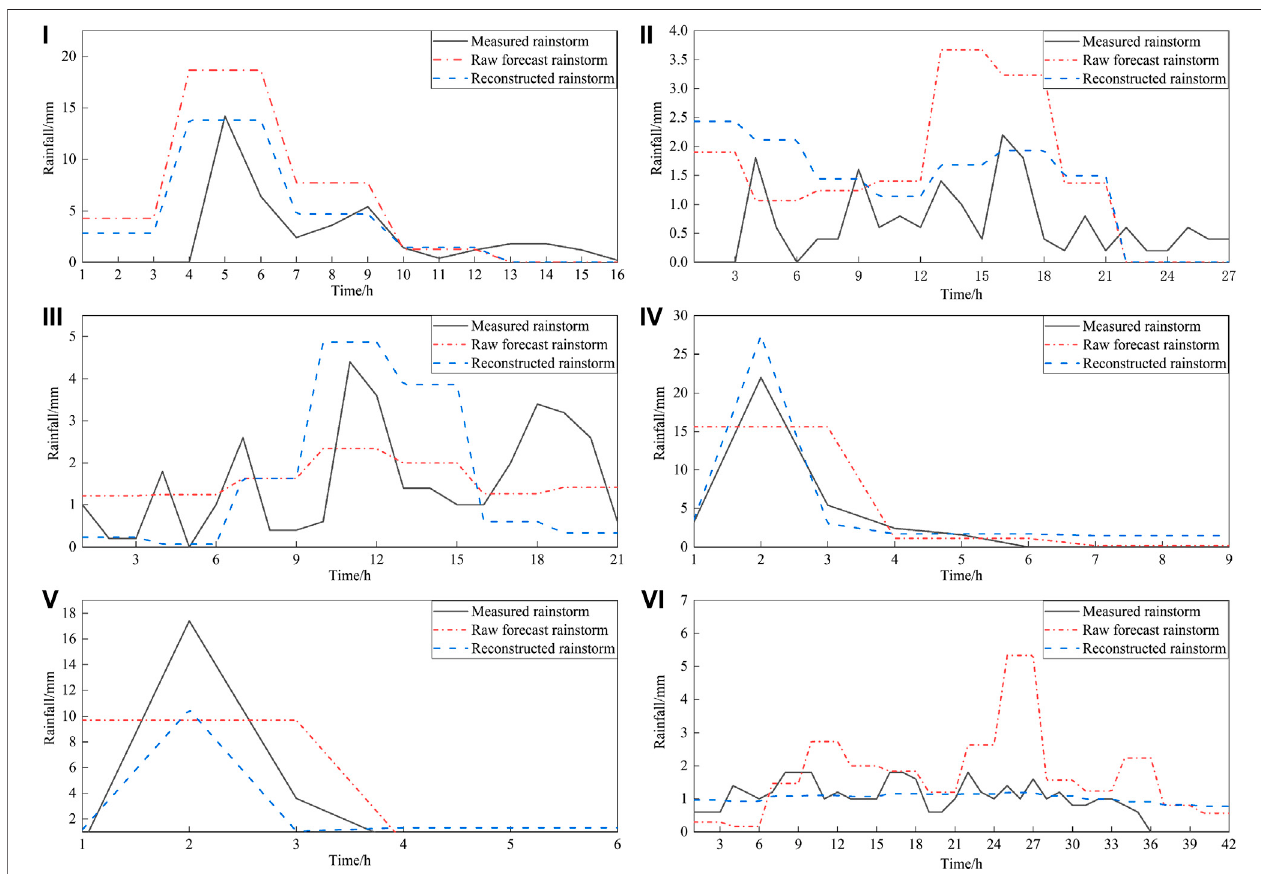
FIGURE6| Thecomparison ofrainfallprocesswithand withoutthereconstructed method: thelabels “ I-VI ” representtheserial numberofsixrainstorms;theblack solid line isthe rainfall data measured by the weather station; the red dashed line isthe raw GRAPES_MESO forecast data; the blue dashed line isthe newforecast data generated by the reconstruction method.